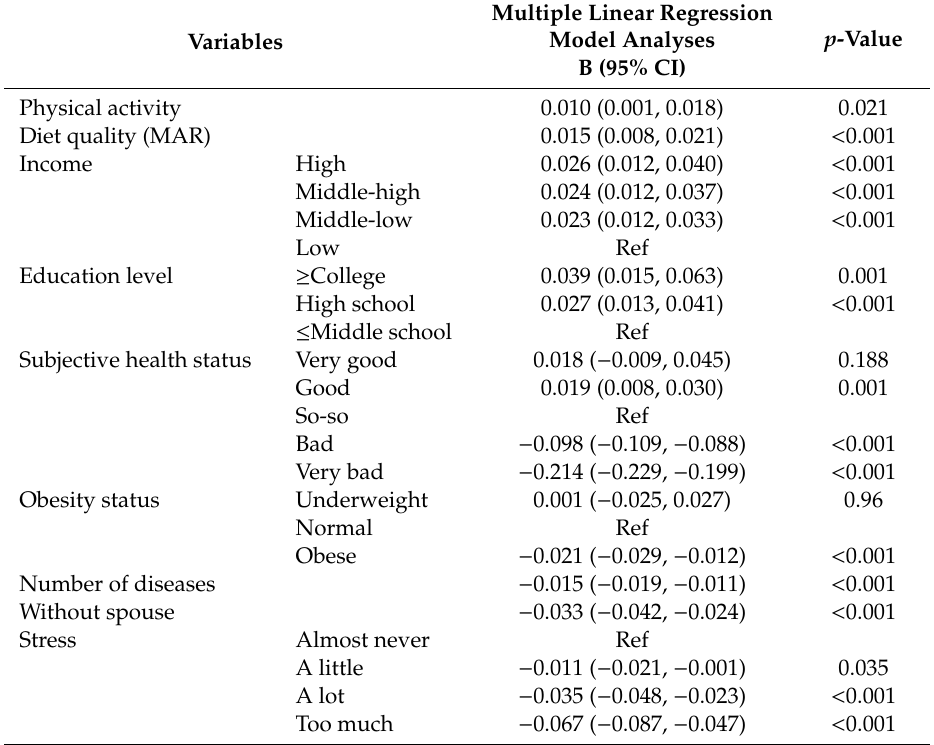
Table 6. Linear logistic regression analyses of factors associated with quality of life (QoL) in Korean older